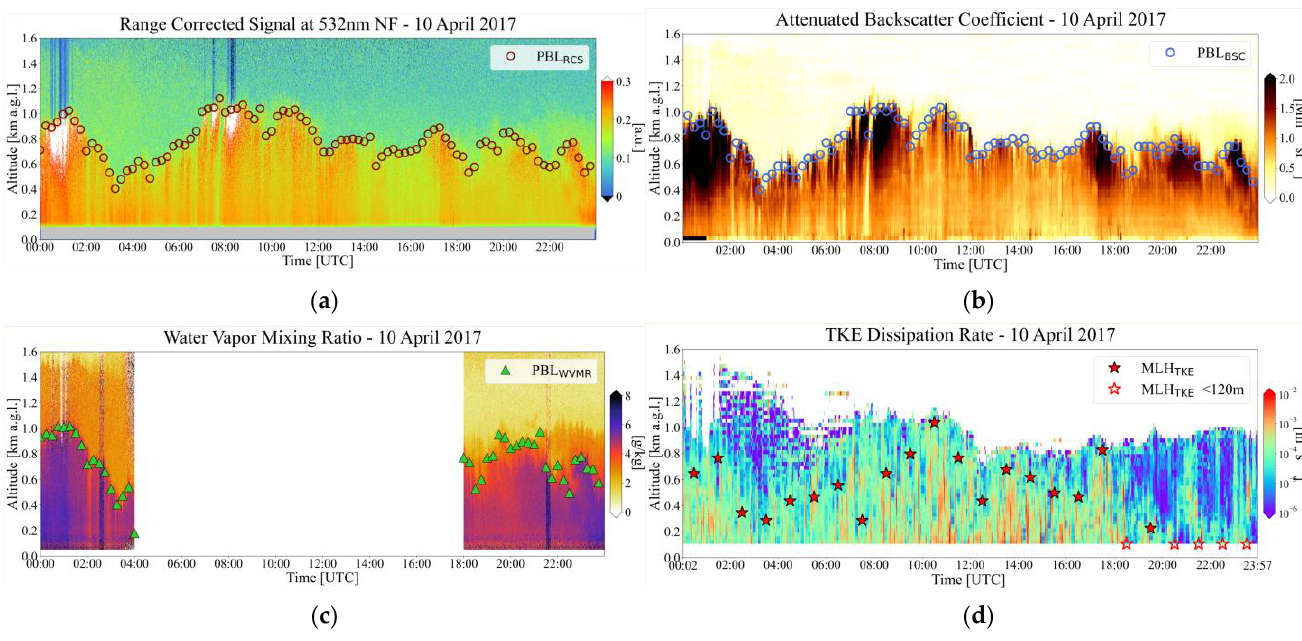
Figure 7. PollyXT Lidar ( a , c ) and Halo Wind Doppler Lidar ( b , d ) products for 10 April 2017: ( a ) Range Corrected Signal (RCS) at 532 nm NF channel (Grey color at the bottom of the Figure, identifies the incomplete overlap of PollyXT Lidar) — Brown circles: PBL height from Wavelet Covariance Transform (WCT) on RCS (PBL RCS ); ( b ) Attenuated Backscatter Coefficient (BSC) — Blue circles: PBL height from WCT on BSC (PBL BSC ); ( c ) Water Vapor Mixing Ratio (WVMR) — Green Triangles: PBL height from WCT on WVMR (PBL WVMR ); ( d ) Turbulent Kinetic Energy dissipation rate (TKE dr ) — Red stars: Mixing Layer Height (MLH) from Threshold Method (TM) on TKE dr (MLH TKE ).